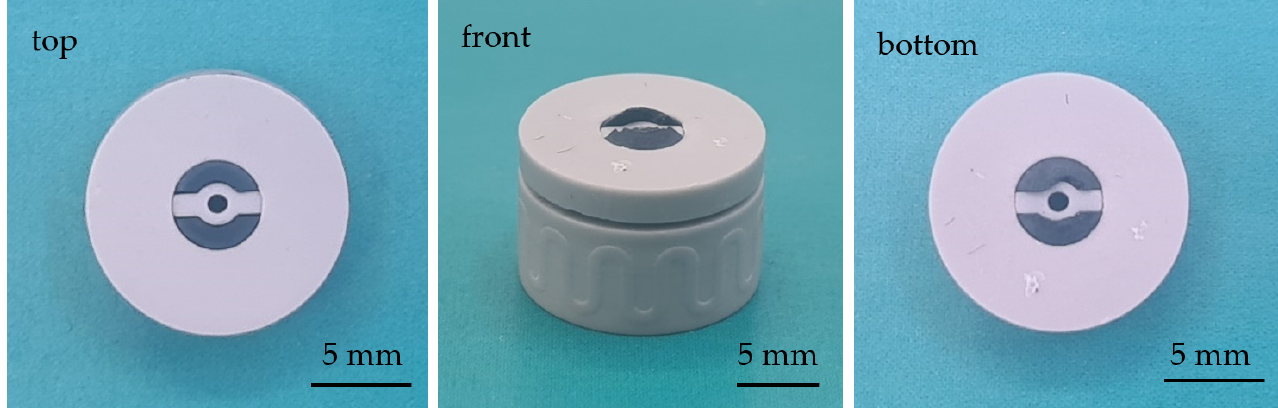
Figure 11. Co ‐ sintered core–shell assembly; zirconia (gray) and electrically conductive titanium suboxide (blue ‐ black) .